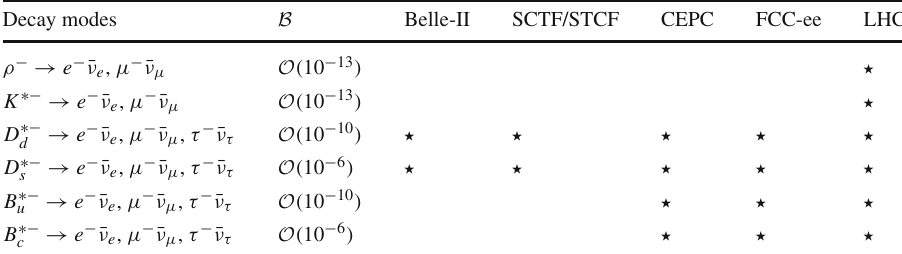
Decay modes B Belle-II SCTF/STCF CEPC